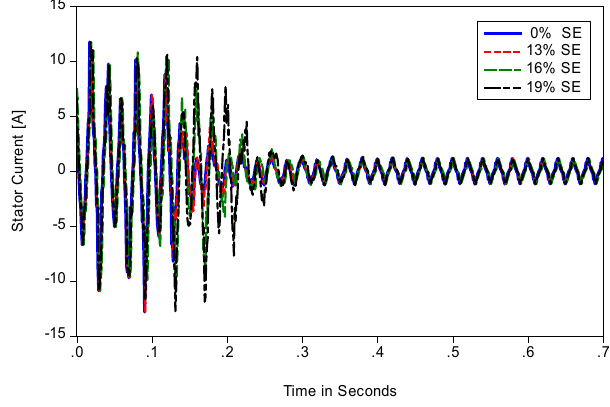
Figure 12. Stator Current under different values of static eccentricity (SE).